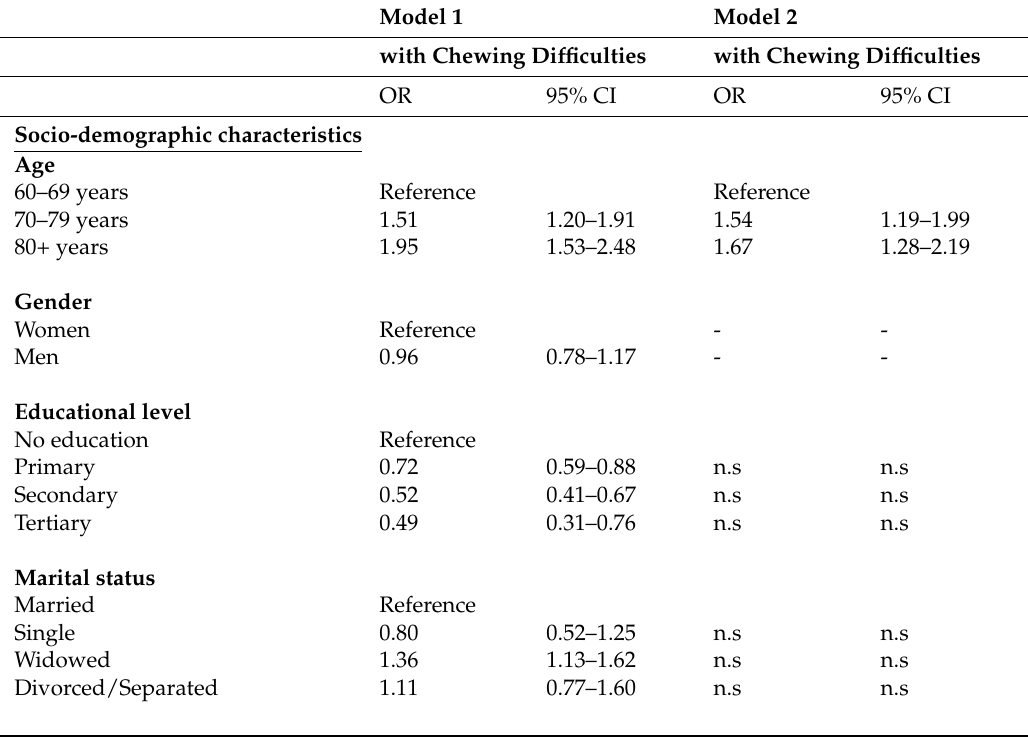
Table 2. Odds ratio (OR) of socio-demographic characteristics, geriatric syndromes, chronic diseases, number of medications, and use of health services at